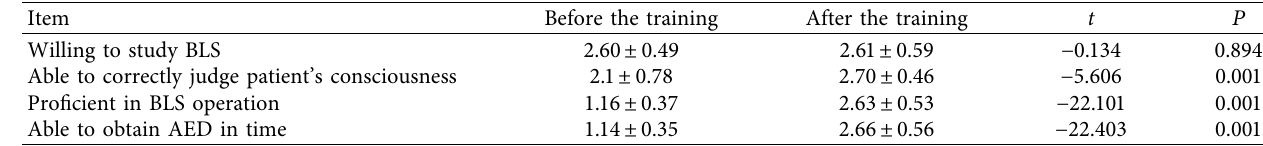
Table 4: Comparison of BLS behavior scores of community residents before and after the training ( x ± s ,